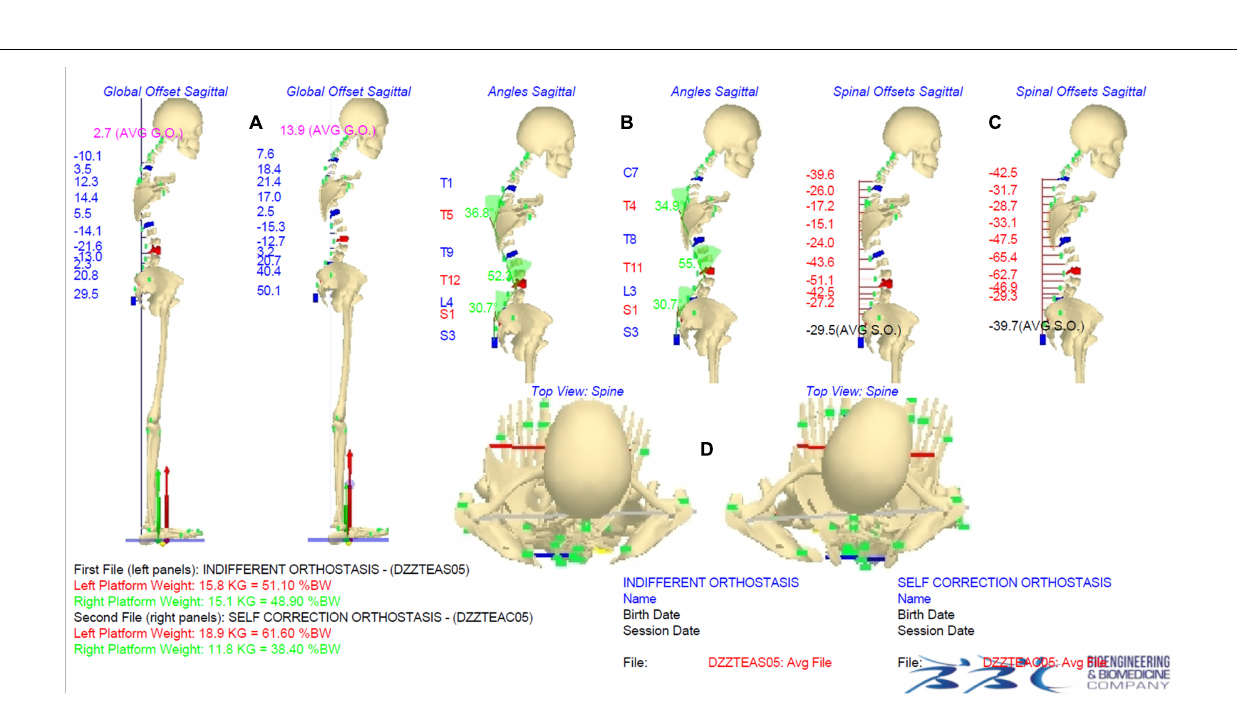
FIGURE 2 | Indifferent orthostasis (IO) vs. instinctive self-correction (ISCO) maneuver comparison graphical report. Panels (A–C) show the comparison IO (left side) vs. ISCO (right side) in the frontal plane of averaged global offsets (AGO), spinal deformities, and Cobb angle values, and averaged spinal offsets (ASO), respectively. Panel (D) shows comparison IO (left side) vs. ISCO (right side) of rotations in the horizontal plane (shoulder girdle/pelvis). Underfoot loads are represented by vertical forces vectors (red vector on the left side, green vector on the right side) graphically showing the | (cid:49) UL| parameter.